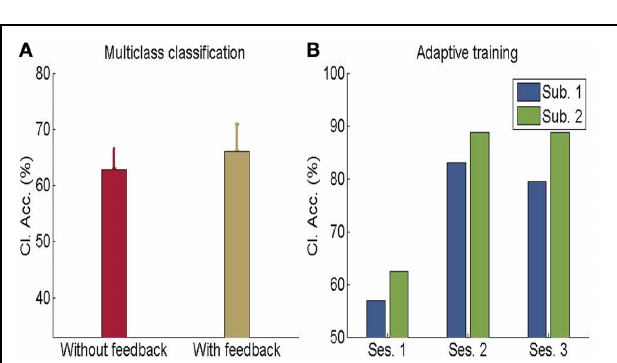
FIGURE 10 | (A) Classification accuracy for multi-class emotion data (happy, sad, disgust) with feedback or without feedback (The chance level is 33%) (B) Performance of adaptive classifier in participants demonstrating increase in classification accuracy when the classifier was adaptively re-trained by combining previous training dataset with data from every new feedback training run. [Adapted from Sitaram et al.